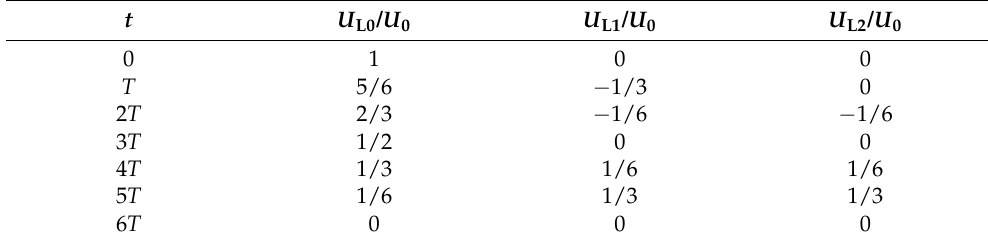
Table 1. Voltage amplitudes in